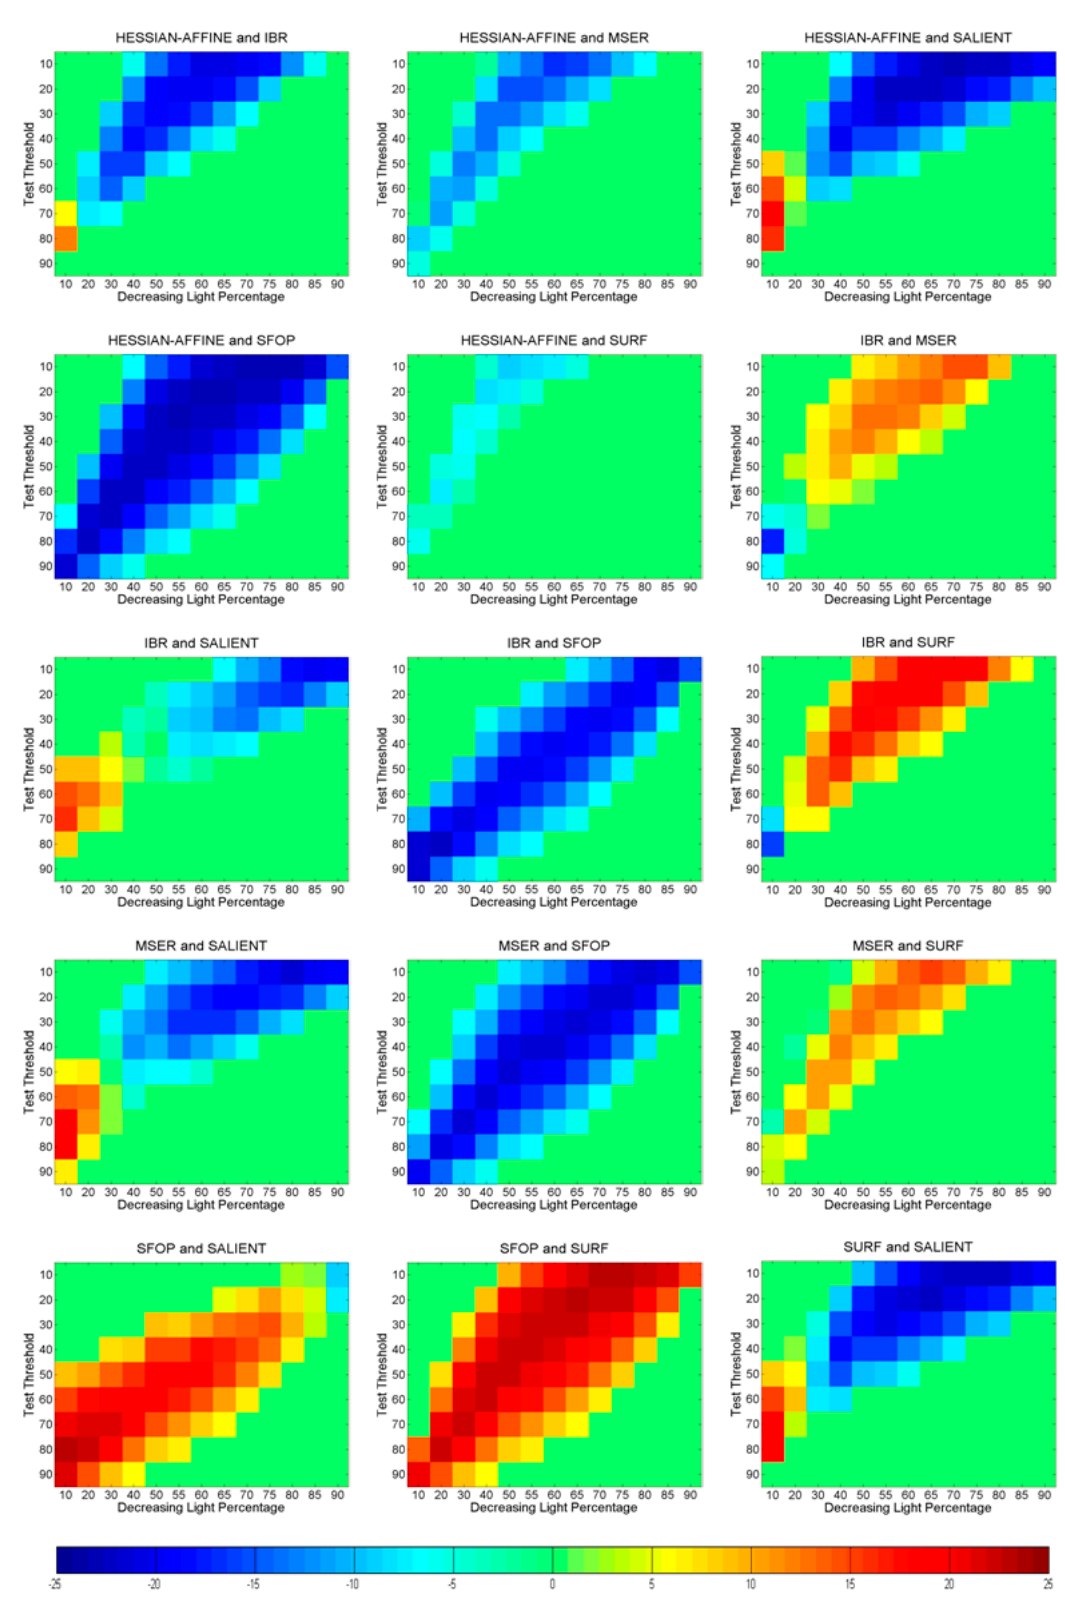
Figure 18. Results of uniform light changes for Hessian-Affine, IBR, MSER, SFOP and SURF with other detectors showing Z -scores; positive Z -scores show that the first detector is better than the second whereas negative values show the converse.